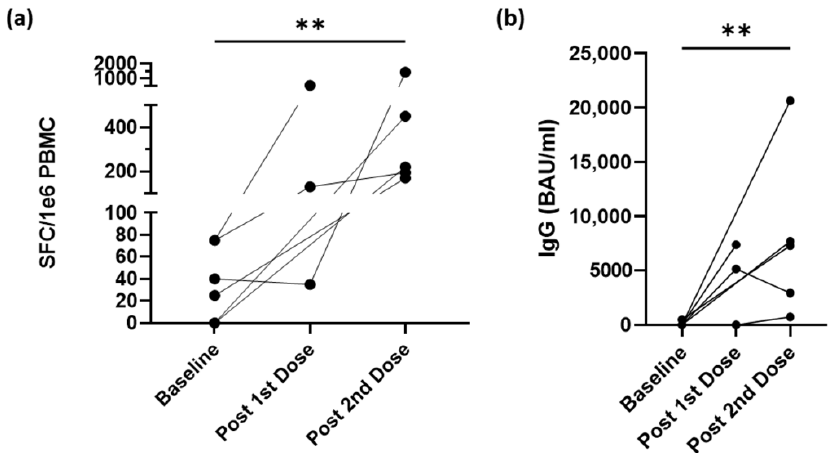
Figure 3. Vaccination increases immune response to SARS-CoV-2 spike protein in oncology workers. ( a ) Spike-specific CD4 + T-cell responses measured using IFN- γ ELISpot, from PBMCs isolated before vaccination (baseline), and 2 weeks following additional doses of a mRNA-based vaccine ( n = 6). ( b ) Spike-specific IgG antibody response measured using ELISA from serum from same partic- ipants. Kruskal – Wallis test was used for group comparisons. Abbreviations: IFN- γ , interferon